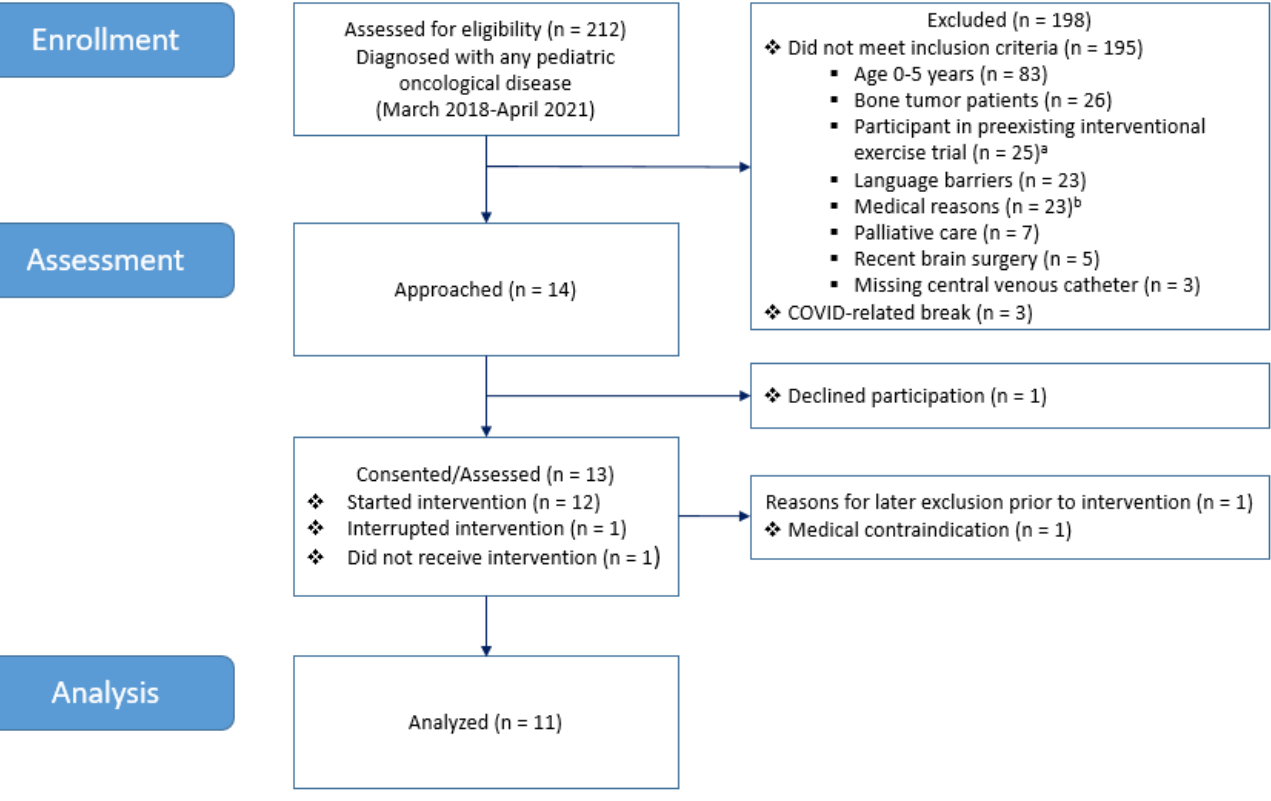
Figure 3. Flowchart of recruitment and study participation. n , number. a pre-existing exercise intervention study (ClinicalTrials.gov Identifier NCT03934060). b medical reasons for exclusion: severely reduced capacity ( n = 13), treatment at intensive care unit ( n = 3), osteoporotic vertebral compression fractures ( n = 3), inability to sit/walk ( n = 2), ventilated ( n = 1), and severe comorbidity ( n =